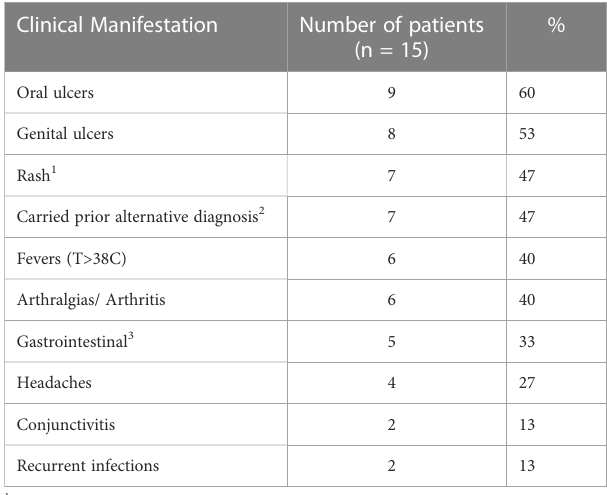
TABLE 1 Prevalence of clinical features in our series of 15 RAID patients from 4 families. Clinical